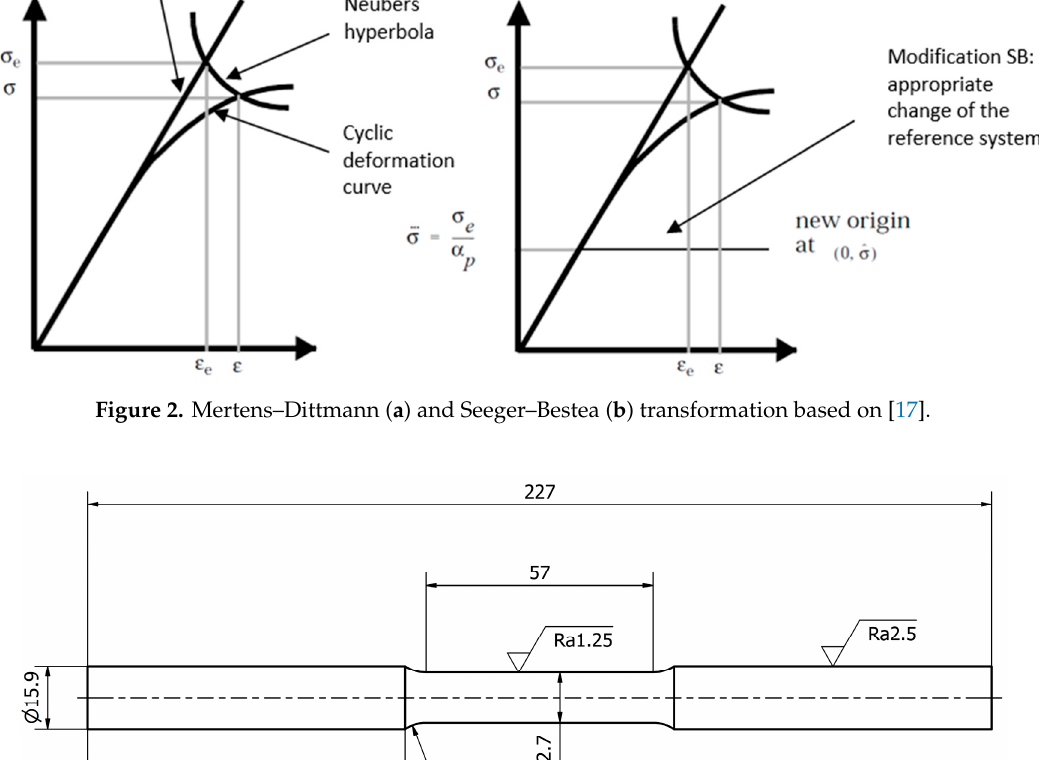
Figure 3. Shape and dimensions of the 0H18N9 tensile test specimen. Table 1. Important mechanical properties of 0H18N9 steel.